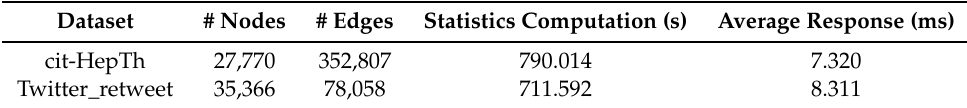
Table 2. Execution time: computation of graph